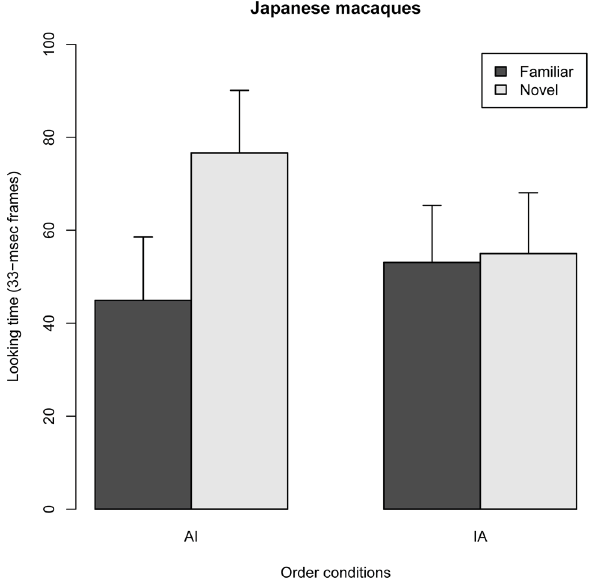
Figure 3. Looking times (LTs) for the stimulus novelty and order conditions in 11 Japanese macaque subjects. In the AI condition, the adult image was used as the stimulus in the familiar phase and the infant image served as the novel stimulus in the test phase. In the IA condition, the infant image was used as the stimulus in the familiar phase and the adult imaged served as the novel stimulus in the test phase. Error bars represent mean values 6 95% confidence intervals. Black bars, familiar stimuli; white bars, novel stimuli.